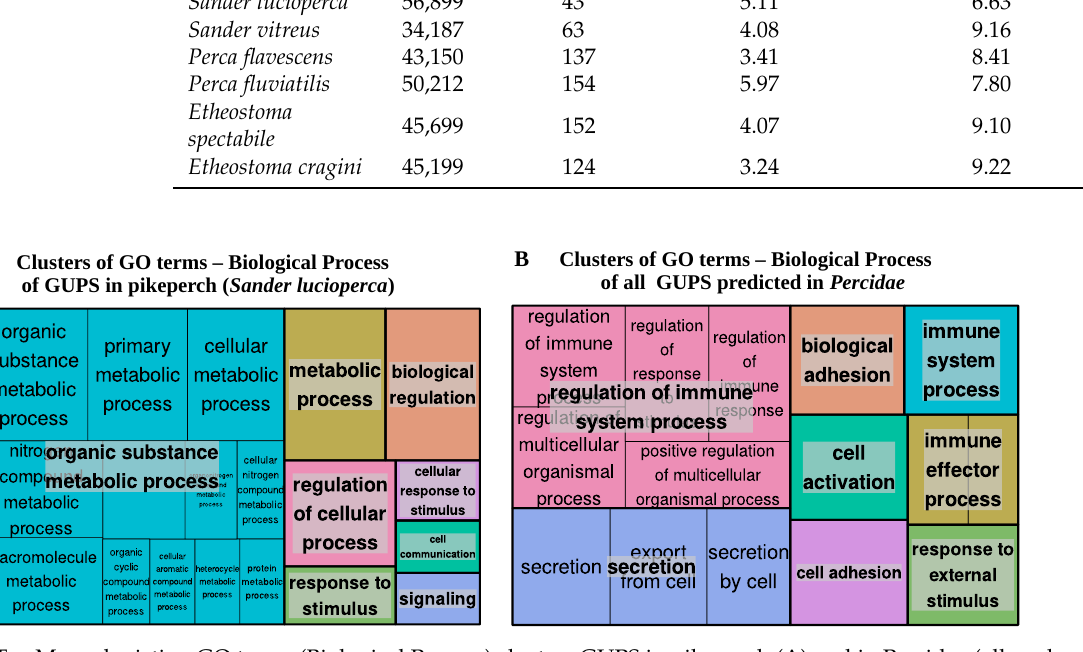
Figure 8. TreeMaps depicting GO terms (Biological Process) clusters GUPS in pikeperch ( A ) and in Percidae (all analysed species) ( B ), respectively. Each rectangle represents a cluster of related GO terms. The sizes of rectangle reflect the significance of the cluster (# of GO terms included in the cluster). Closely related GO terms are grouped together in a super-cluster of the same